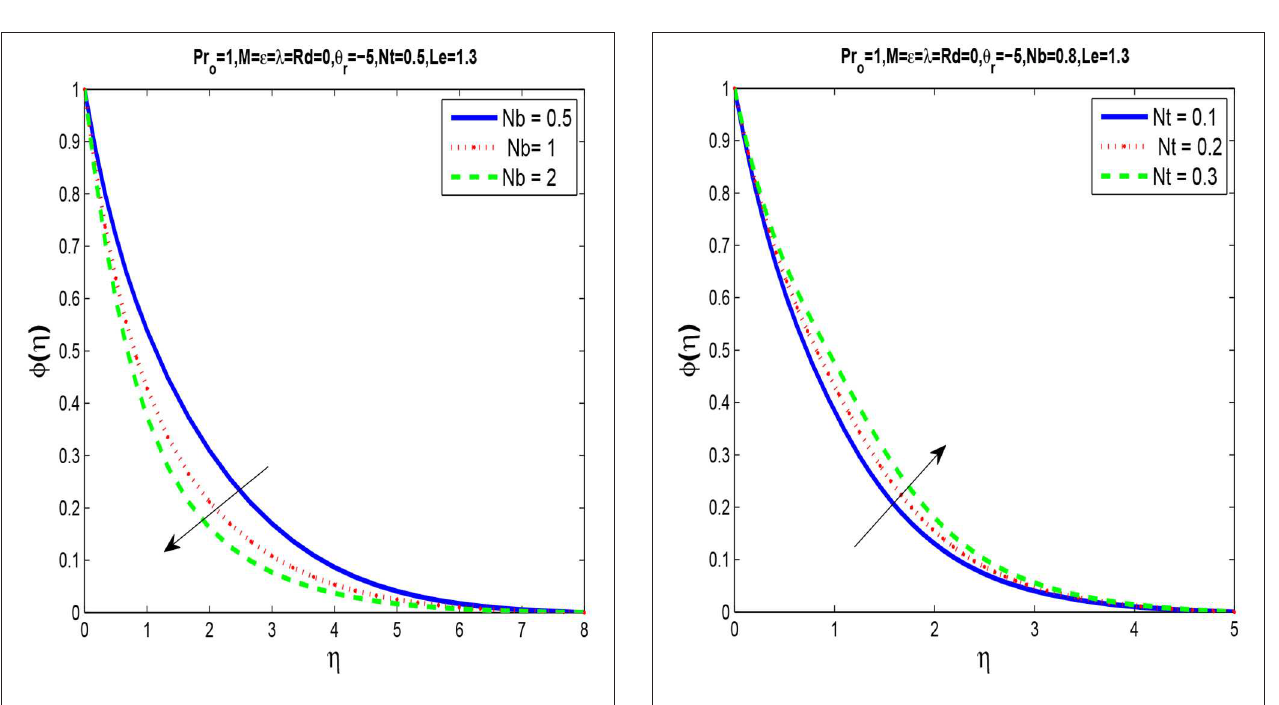
Figures 5 , 6 are plotted for different values of Brownian motion parameter N b and we observe that by increasing N b thermal boundary layer thickness increases while concentration boundary layer decrease by increasing N b